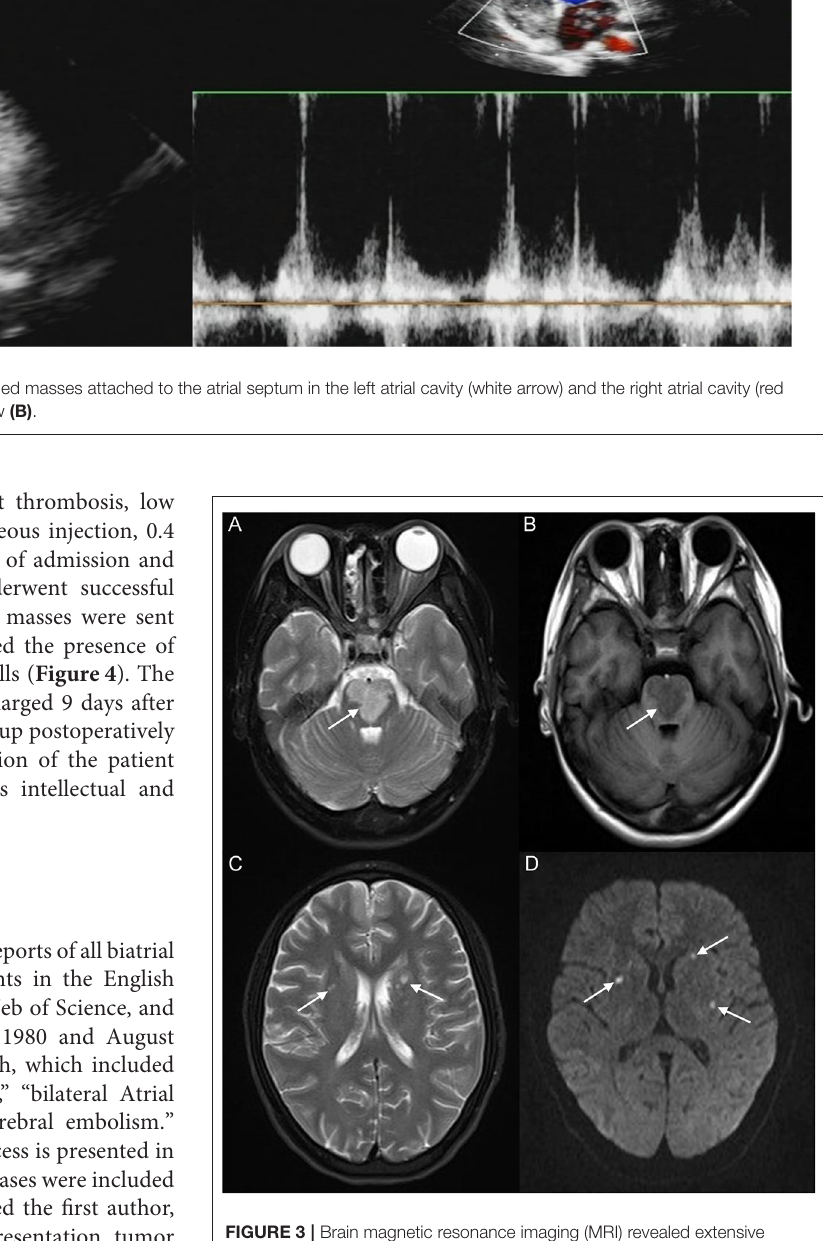
FIGURE 3 | Brain magnetic resonance imaging (MRI) revealed extensive hyperintensity on T 2 -weighted imaging and hypointensity on T 1 -weighted imaging of the bilateral parts of the pons (white arrow) (A,B) ; a patchy hyperintensity on T 2 -weighted imaging of the bilateral basal ganglia, bilateral centrum semiovale (white arrow) (C) , and right frontoparietal lobe, which presented a high signal on diffusion-weighted imaging (DWI) (white arrow) (D)